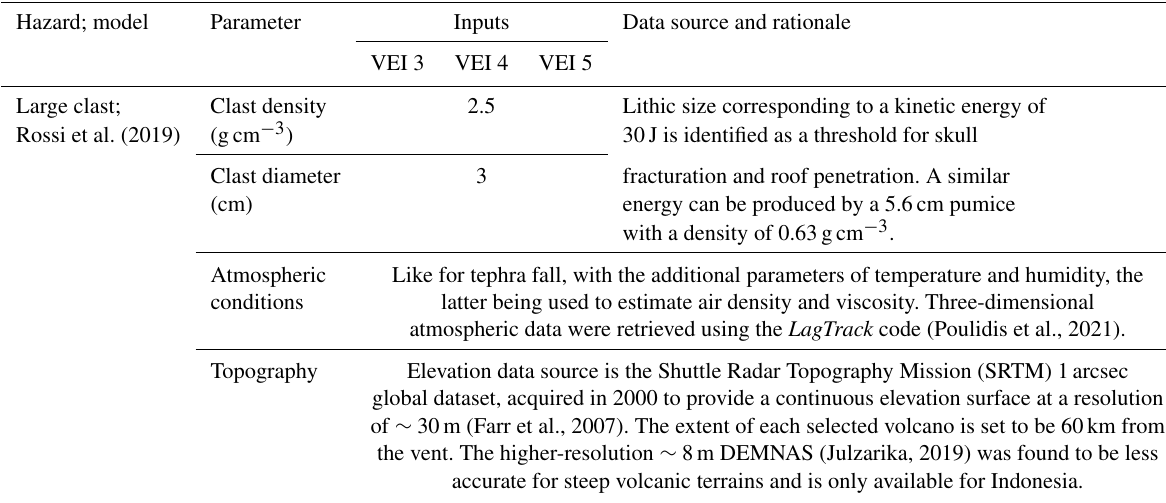
Table A2. Model input parameters and their rationale used for simulating large clast emplacement. Hazard; model